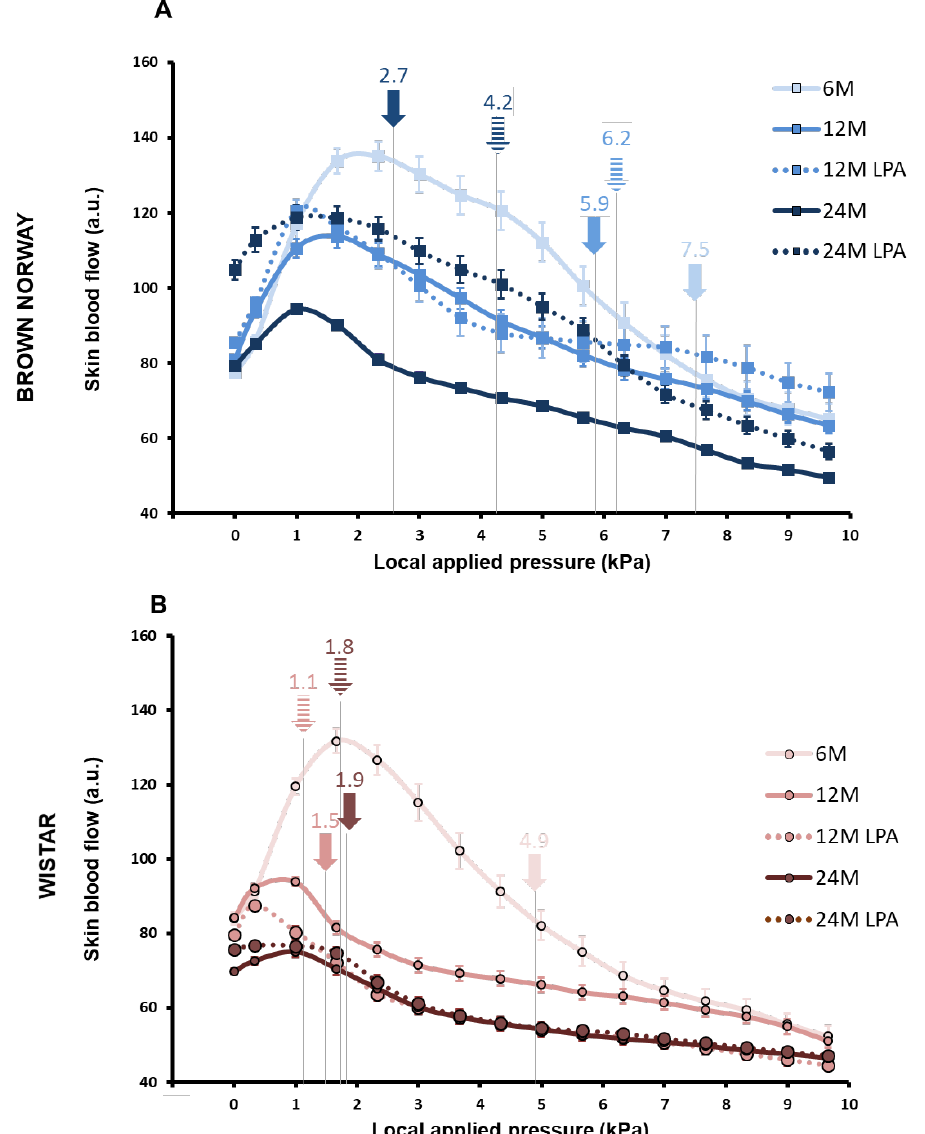
Figure 3. Skin blood flow changes in response to local external pressure application with (hatched lines) or without (solid lines) LPA treatment. The results were obtained for both BN ( A ) and Wistar ( B ) strains for 6 month old (6 M), 12 month old (12 M), and 24 month old (24 M) rats previously fed a diet supplemented with α -lipoic acid (0.5%) for 4 weeks (LPA) or not. In each case, the skin blood flow depending on the pressure applied was registered, and the crushing pressure means (numbers and arrows on the curve for each condition) were noted. Error bars represent the standard error of the mean.